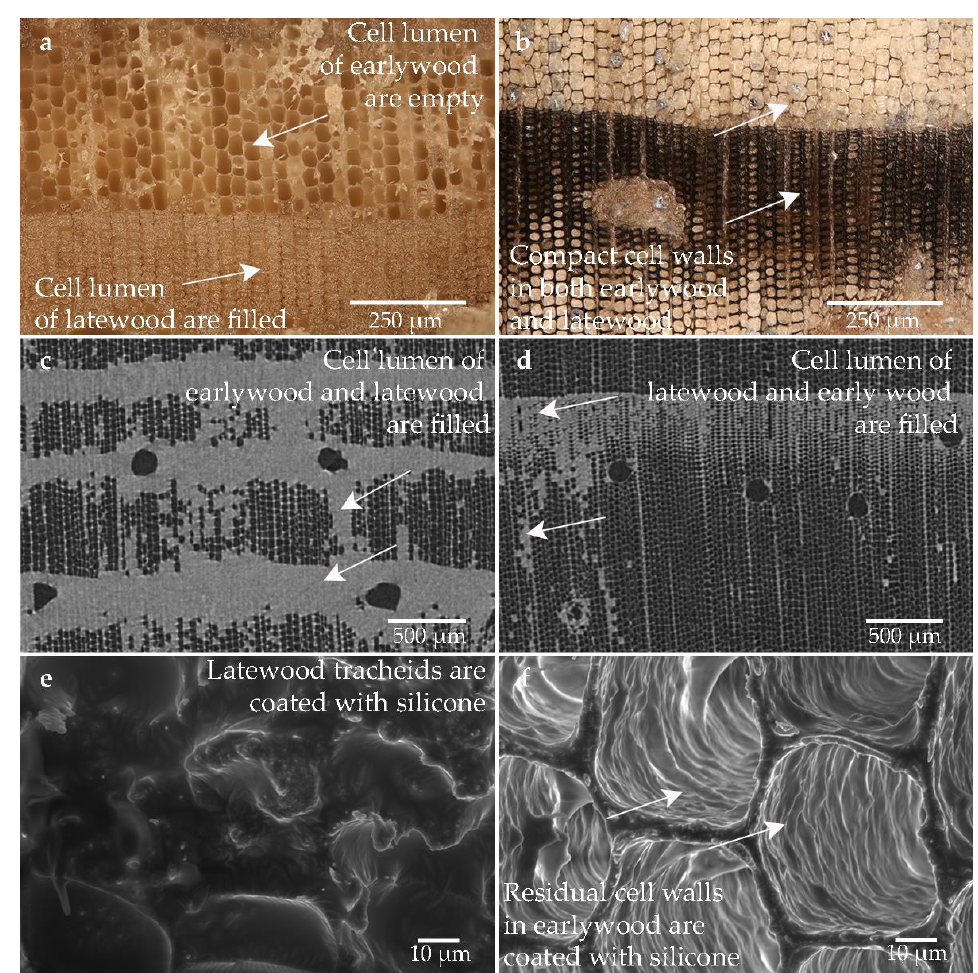
Figure 10. Microscopic wood structure of sample conserved with silicone oil (Pi1-Sil) ( a ) RLM image from the high degraded area; ( b ) RLM image from the low degraded area; ( c ) CT image of the cross section of the high degraded sample; ( d ) CT image of the cross section of the low degraded sample; ( e ) SEM image of the latewood tracheids; ( f ) SEM image of the earlywood tracheids in the heavily degraded area.